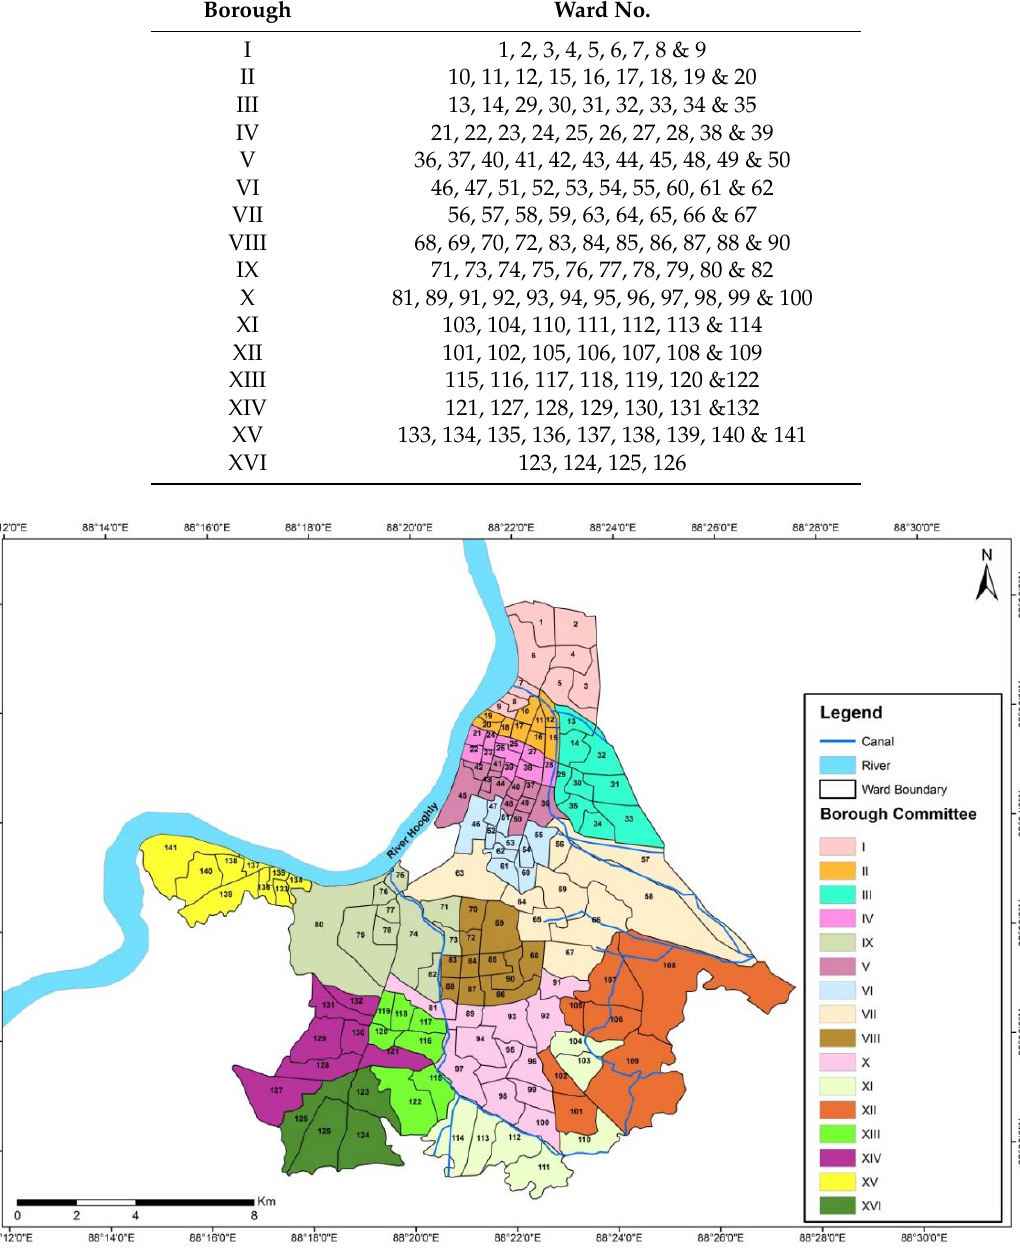
Figure 3. Borough Map of Kolkata Municipal Corporation area featuring all the associated wards for each borough (source: Kolkata Municipal Corporation, 2016).